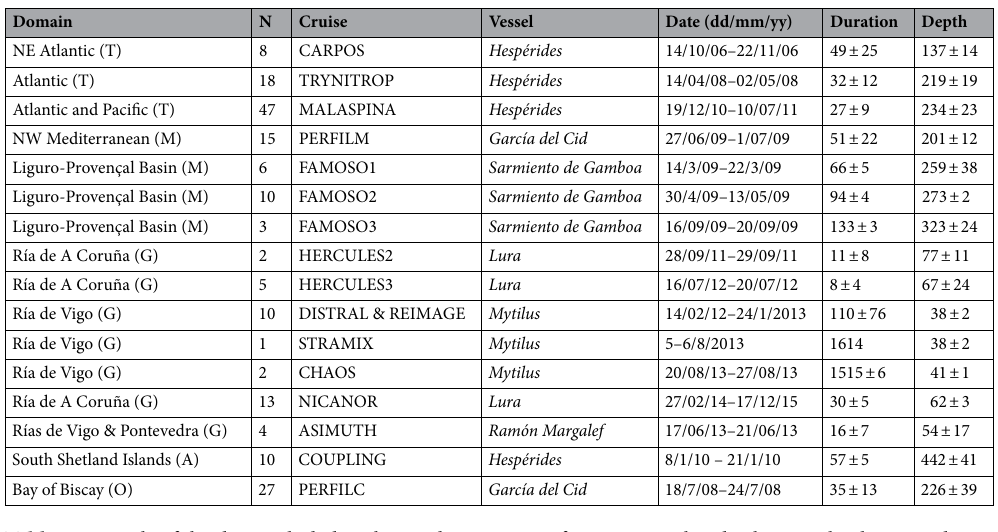
Table 1. Details of the data included in this study. Domain refers to tropical and subtropical Atlantic and Pacific oceans (T), Northwestern Mediterranean Sea (M), Galician coastal upwelling (G), Antarctic Peninsula (A) and other regions (O). N indicates the number of stations sampled during each cruise. Duration (mean ± standard deviation, in minutes) is the time used for the turbulence profiler deployment at each station. Depth (mean ± standard deviation, in meters) is the maximum depth reached by the microstructure profiler. During the Malaspina expedition only 44 out of 47 stations were considered as tropical and